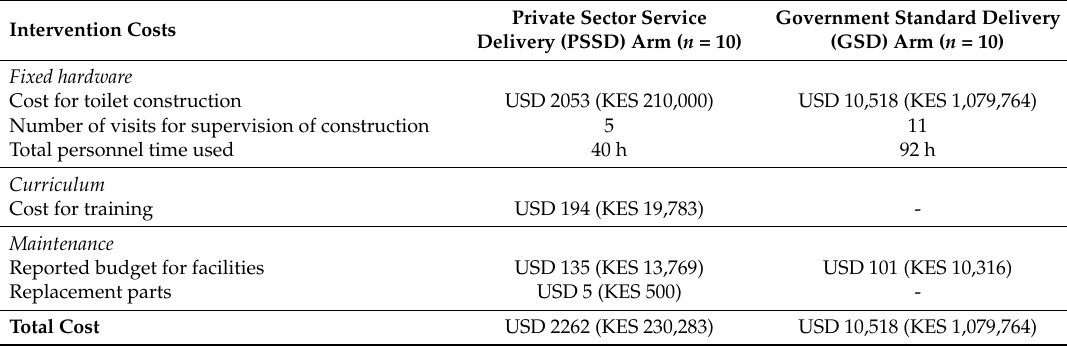
Table 3. Average intervention costs per school for each trial